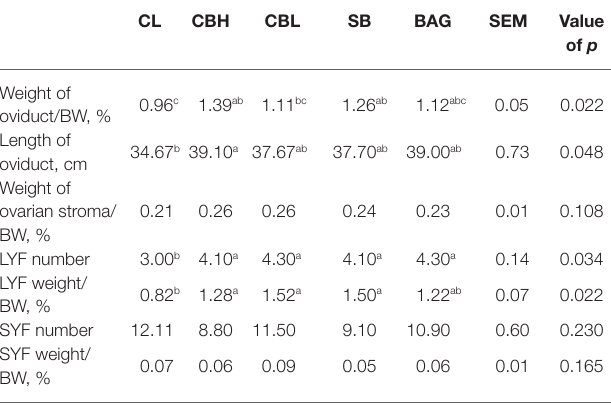
TABLE 4 | Oviduct-related variables of yellow-feathered breeder